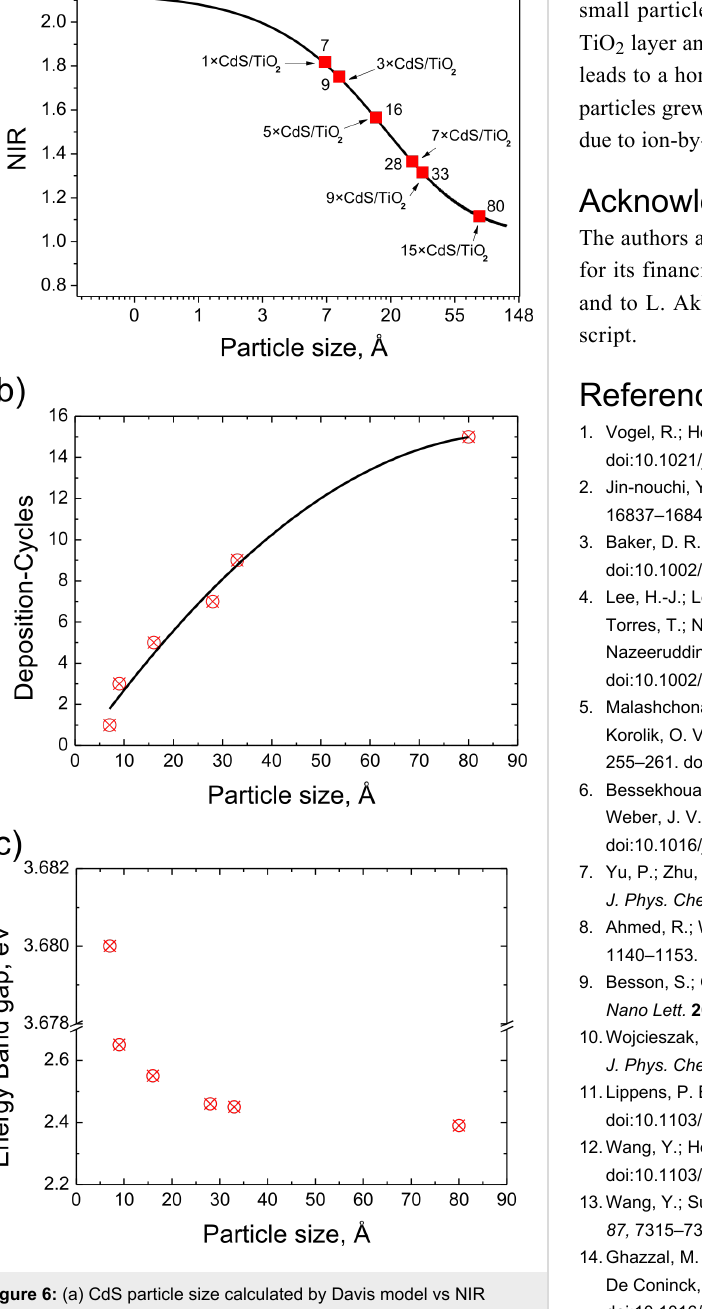
size on the number of successive deposition cycles. Moreover,